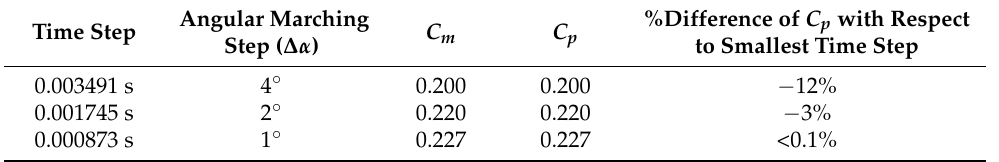
Table 5. Timestep Independence Test for λ =